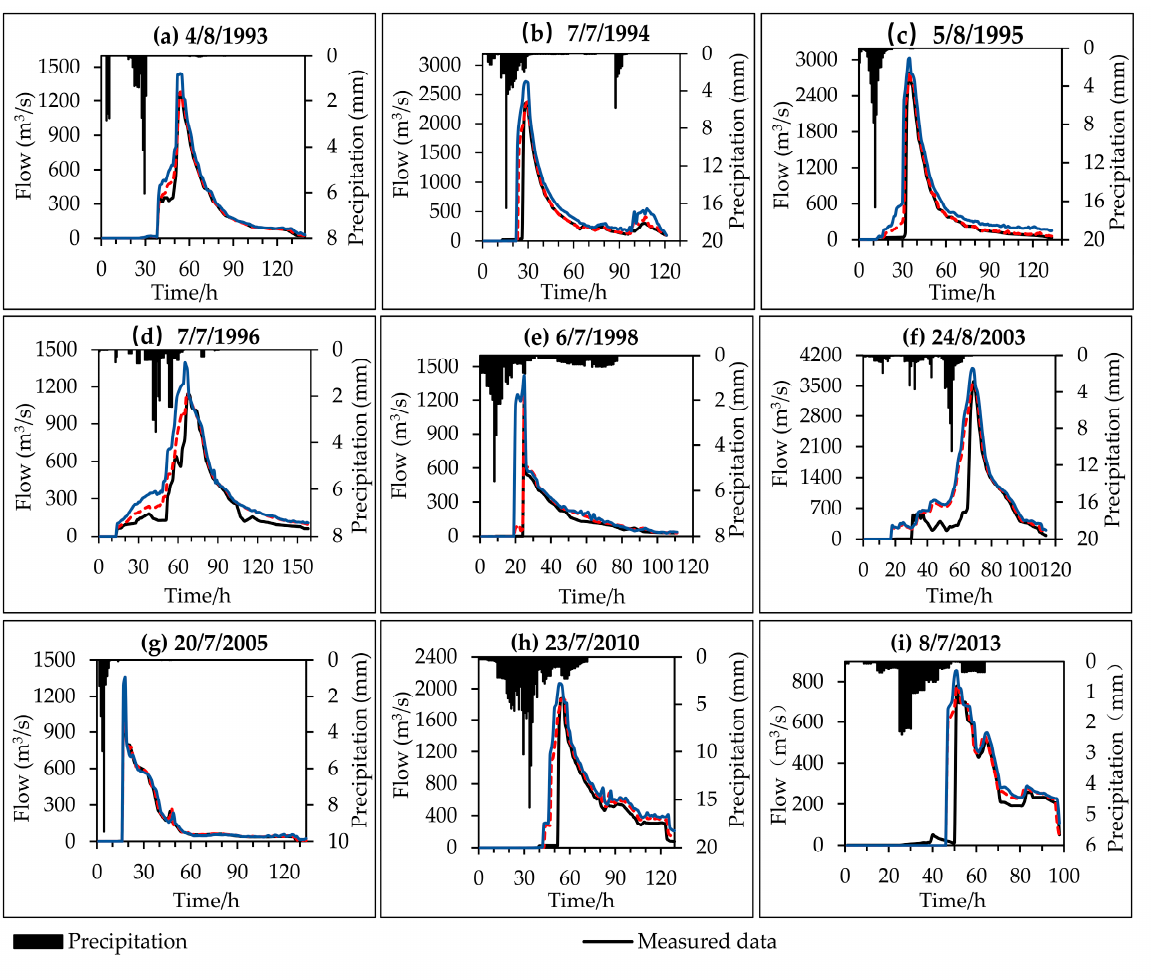
Figure 13. Simulation diagram of the flooding process in the Basin under the changing environment; ( a ) Date of event onset is 4/8/1993; ( b ) Date of event onset is 7/7/1994; ( c ) Date of event onset is 5/8/1995; ( d ) Date of event onset is 7/7/1996; ( e ) Date of event onset is 6/7/1998; ( f ) Date of event onset is 24/8/2003; ( g ) Date of event onset is 20/7/2005; ( h ) Date of event onset is 23/7/2010; ( i ) Date of event onset is 8/7/2013.